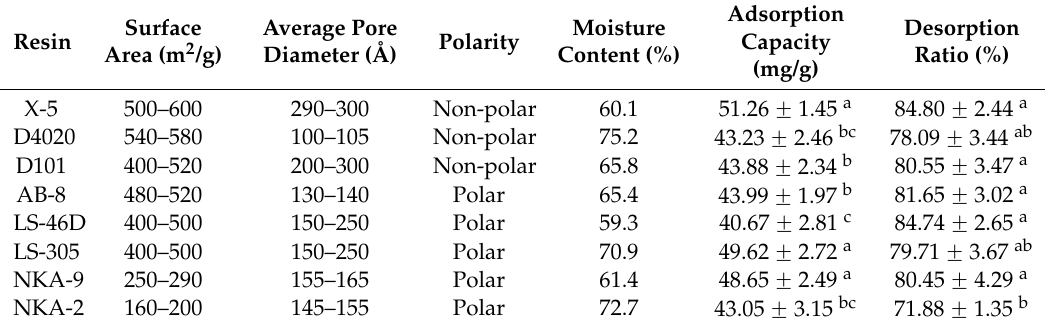
Table 1. Physical properties and results of adsorption capacities and desorption ratios for different macroporous resins.